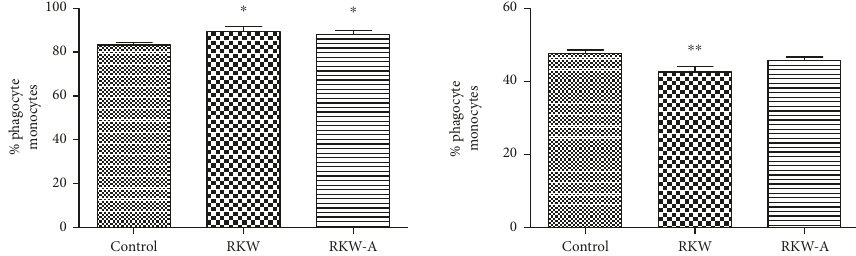
Figure 4: Blood cell phagocytosis. Analysis was performed in the o ff spring of mothers fed during pregnancy and lactation with water (RKW) or hydroalcoholic (RKW-A) extract of Rhodiola kirilowii . ∗ P < 0 05 ; ∗∗ P < 0 01 .